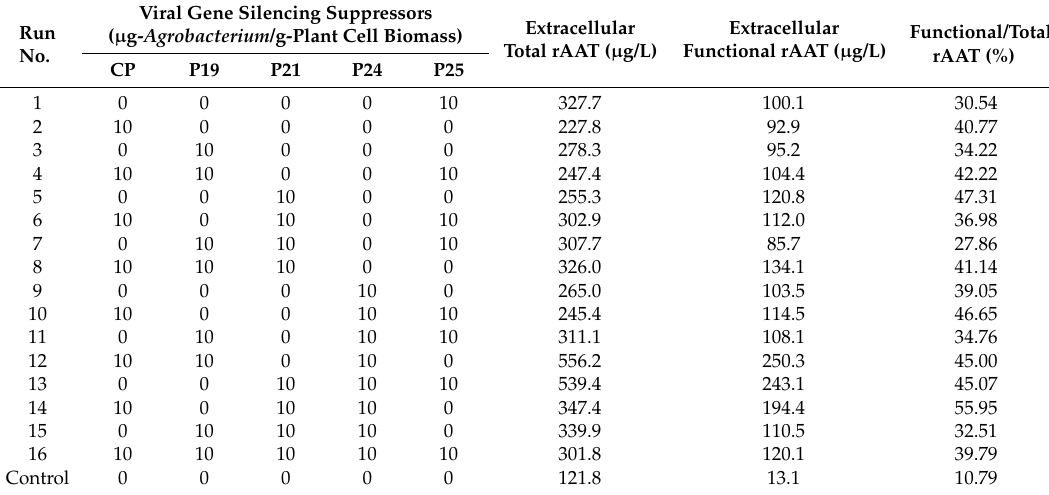
Table 2. Two level fractional factorial design variables (viral gene silencing suppressors) with recombinant human AAT production as response, and its ANOVA result (analysis of variance and regression